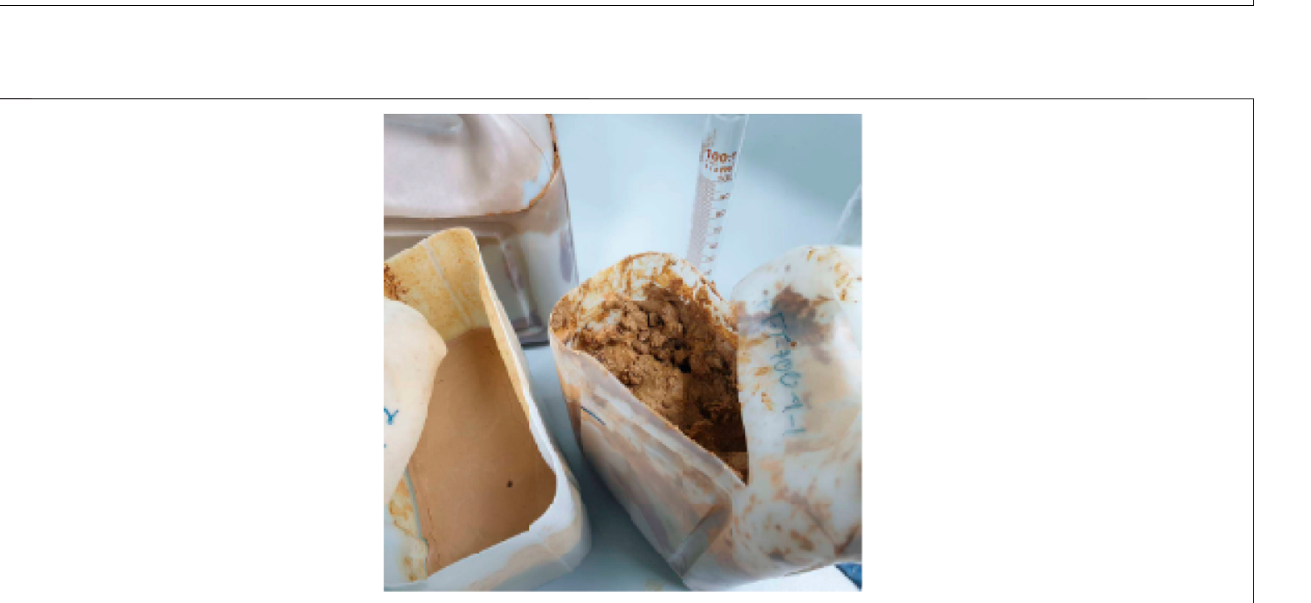
FIGURE 9 | Products obtained from the pyrolysis of HDPE pellets (A) fi rst sample collection (B) second sample collection (10 min after fi rst collection), and (C) the third sample collection (20 min after fi rst collection).